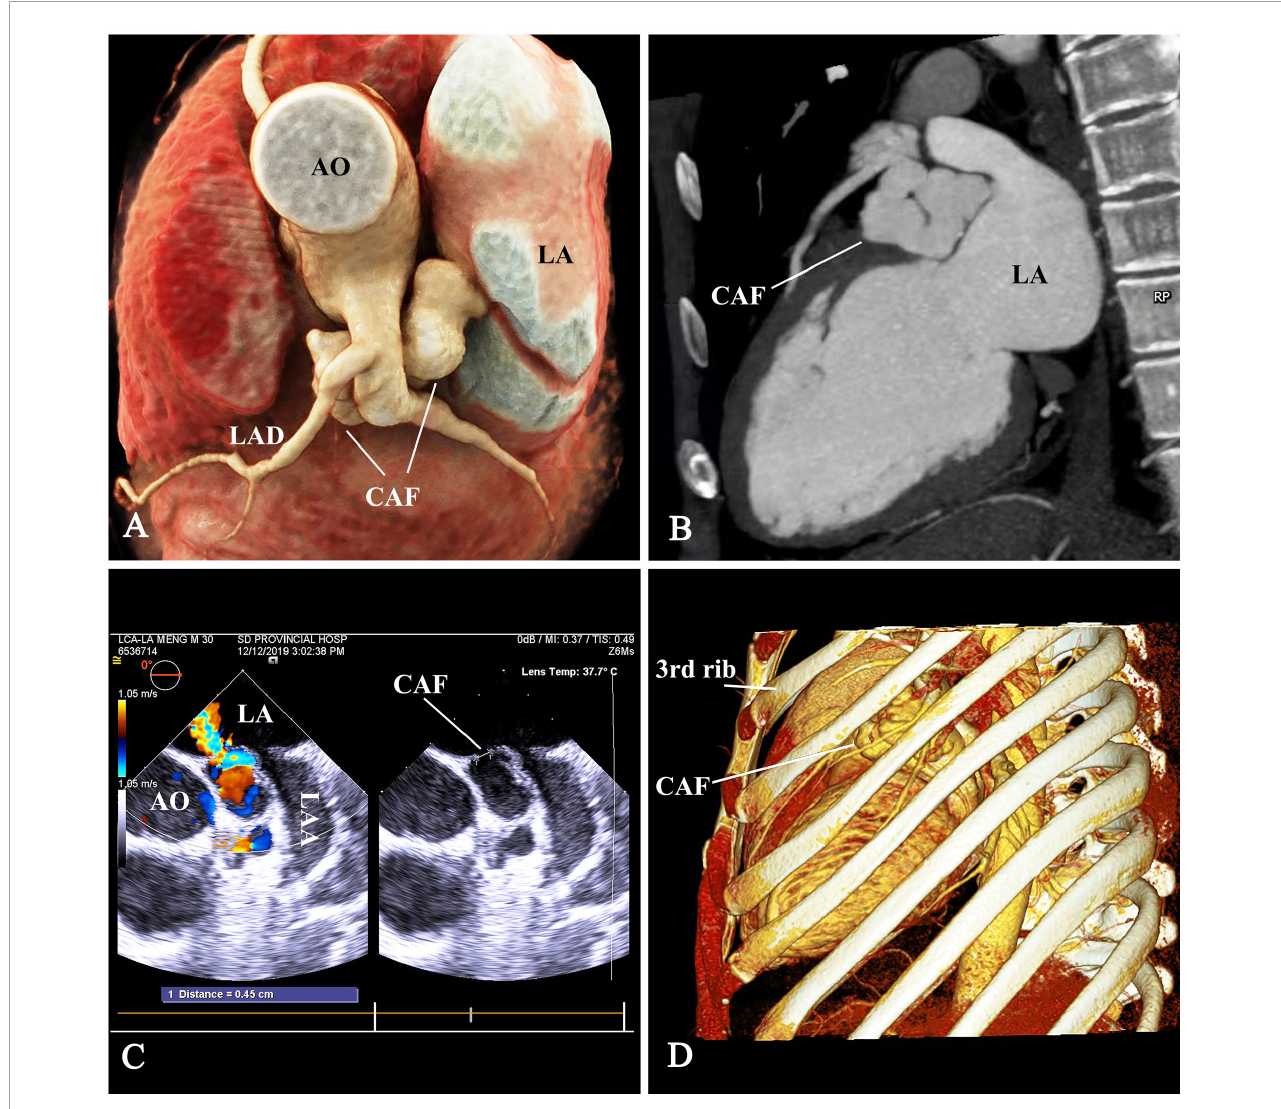
FIGURE1 The anatomy of CAF. (A,B) The tortuous aneurysmal CAF originated from main coronary artery (MCA), made a 180 ◦ turn underneath the LAD and MCA, and coursed backward to drain into the LA. (C) The drainage opening measuring 4.5 mm, was located at the LA roof between the aortic root and LAA. (D) The thoracic computed-tomographic-angiography to determine the access. CAF, coronary artery fistula; AO, ascending aorta; LAD, left anterior descending branch; LA, left atrium; LAA, left atrial